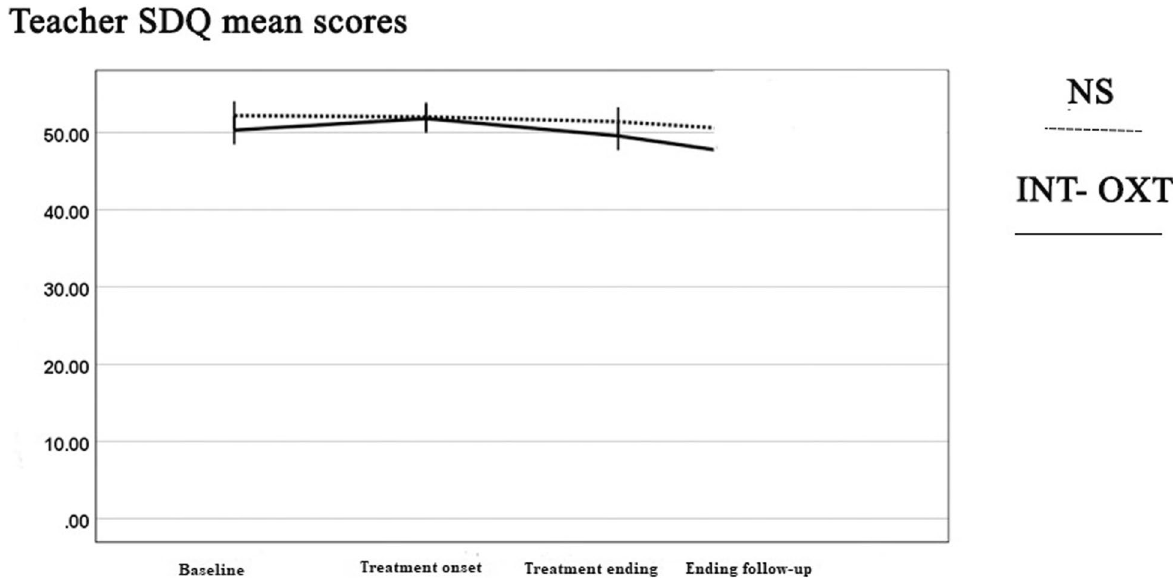
Fig. 4 Changes in the teacher strengths and difficulties questionnaire (SDQ) mean scores in two groups during the study period. INT-OXT, intranasal oxytocin; NS , normal